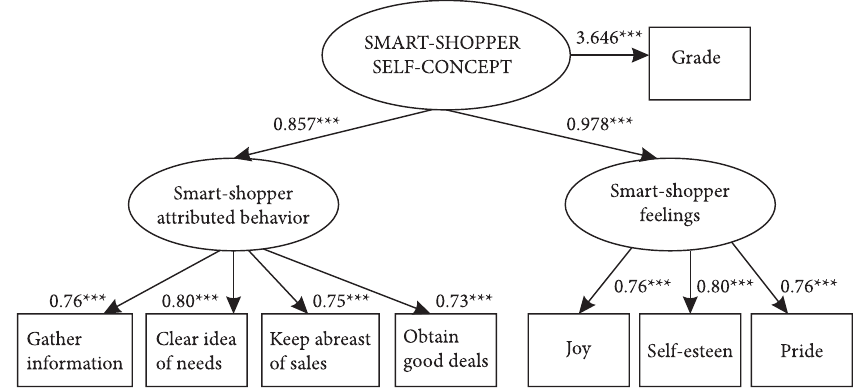
Figure 1. Smart shopping second-order global model